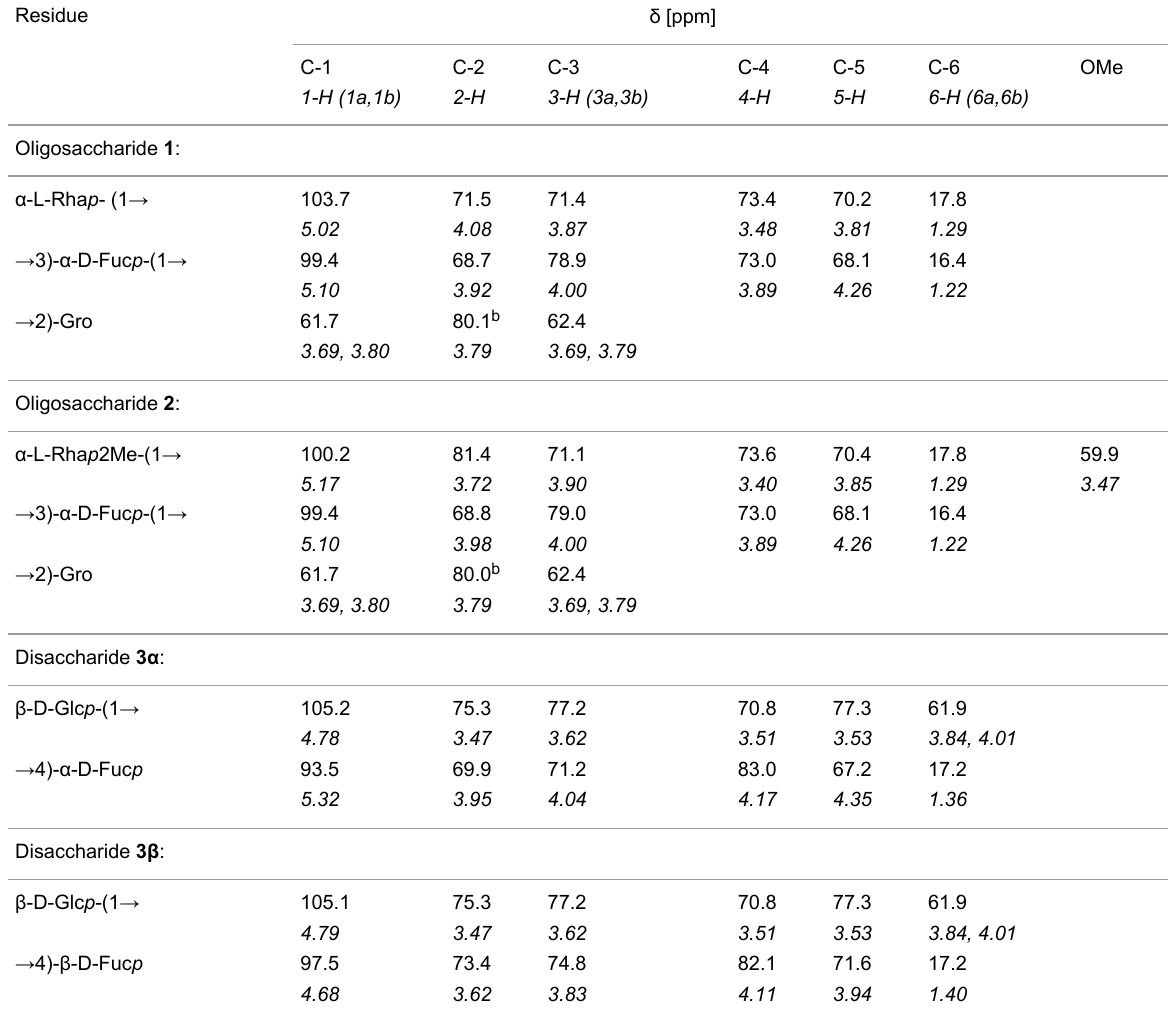
Table 1: 1 H and 13 C NMR chemical shifts of the oligosaccharides derived from the OPS from A. halopraeferens Au4 by Smith degradation ( 1 and 2 ) and solvolysis with CF 3 CO 2 H ( 3 ). a Gro indicates glycerol.